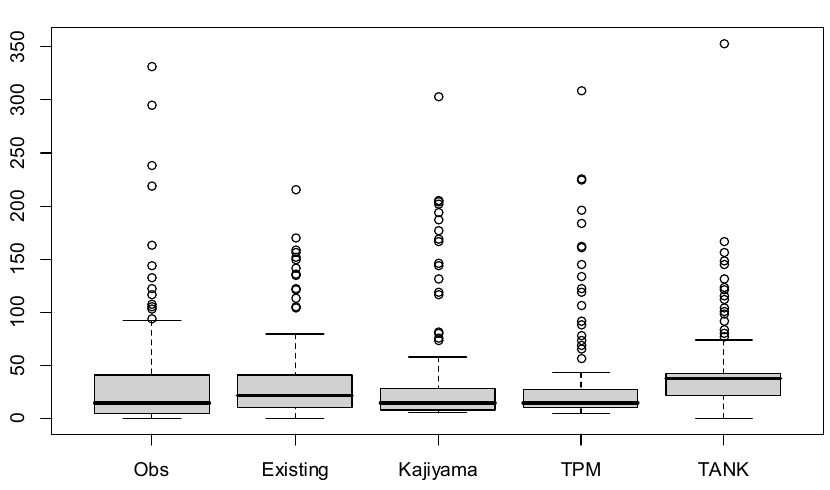
mean and the smallest RMSE. The Nash–Sutcliffe efficiency factor and R 2 values were the largest for the results of the conventional method and the Kajiyama formula, respectively.